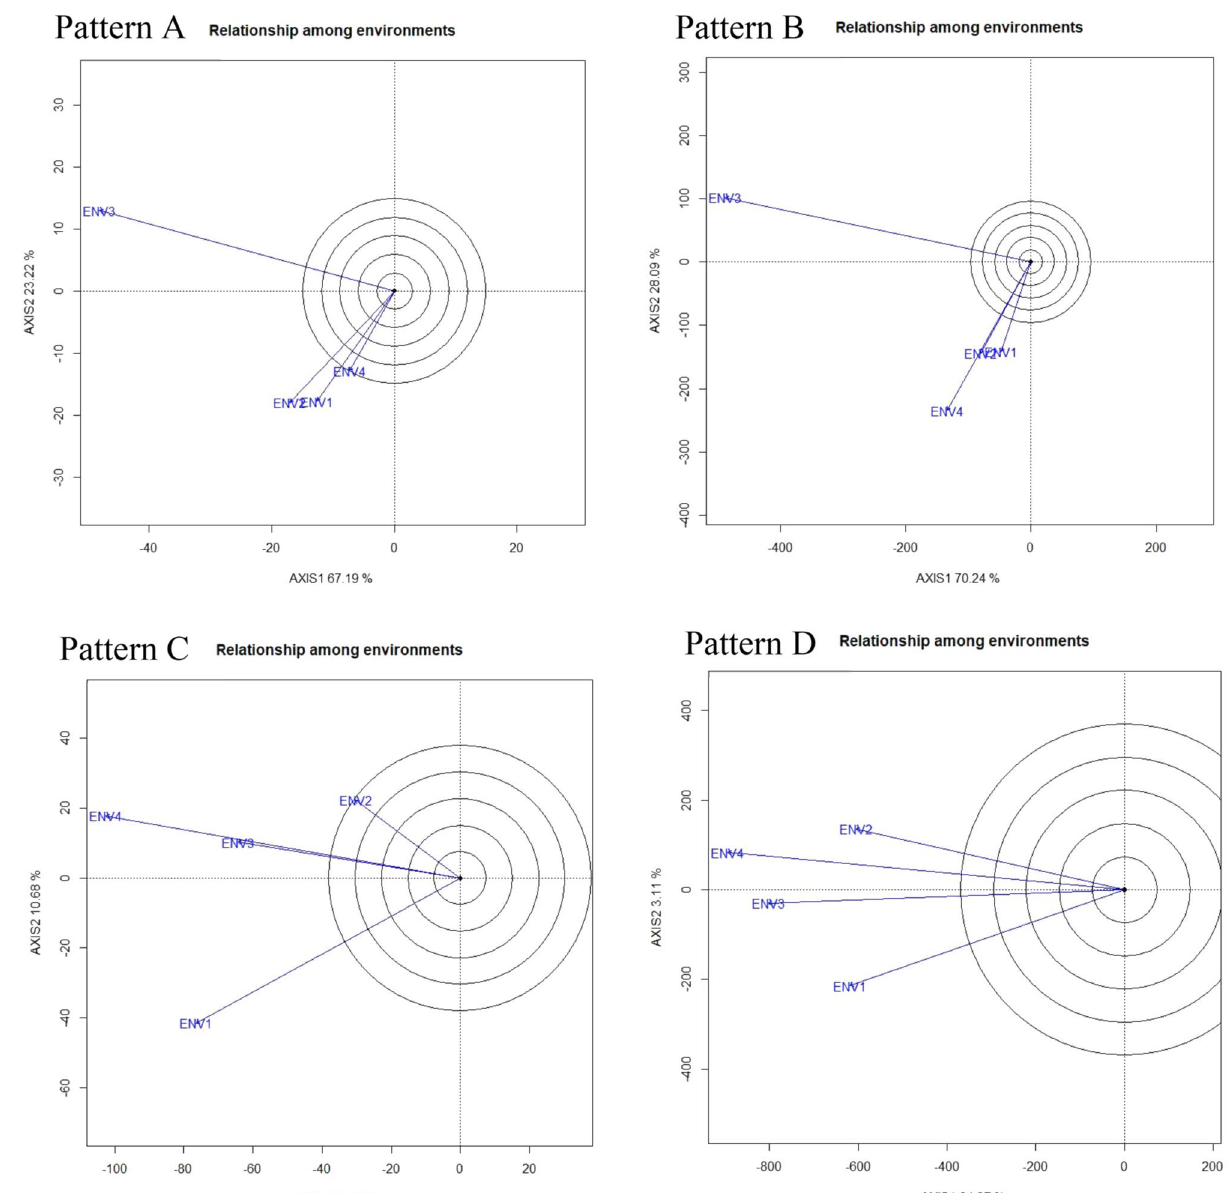
Figure 6. The vector view of GGE biplot showing the relationship among environment (tested environment with the ideal environment) of 30 V . subterranea genotypes under two season two location for total number of pods (Pattern A), fresh pod weight (Pattern B), hundred seed weight (Pattern C), yield per hectare (Pattern D). The biplots were created based on Centering = 0, SVP = 2, Scaling =